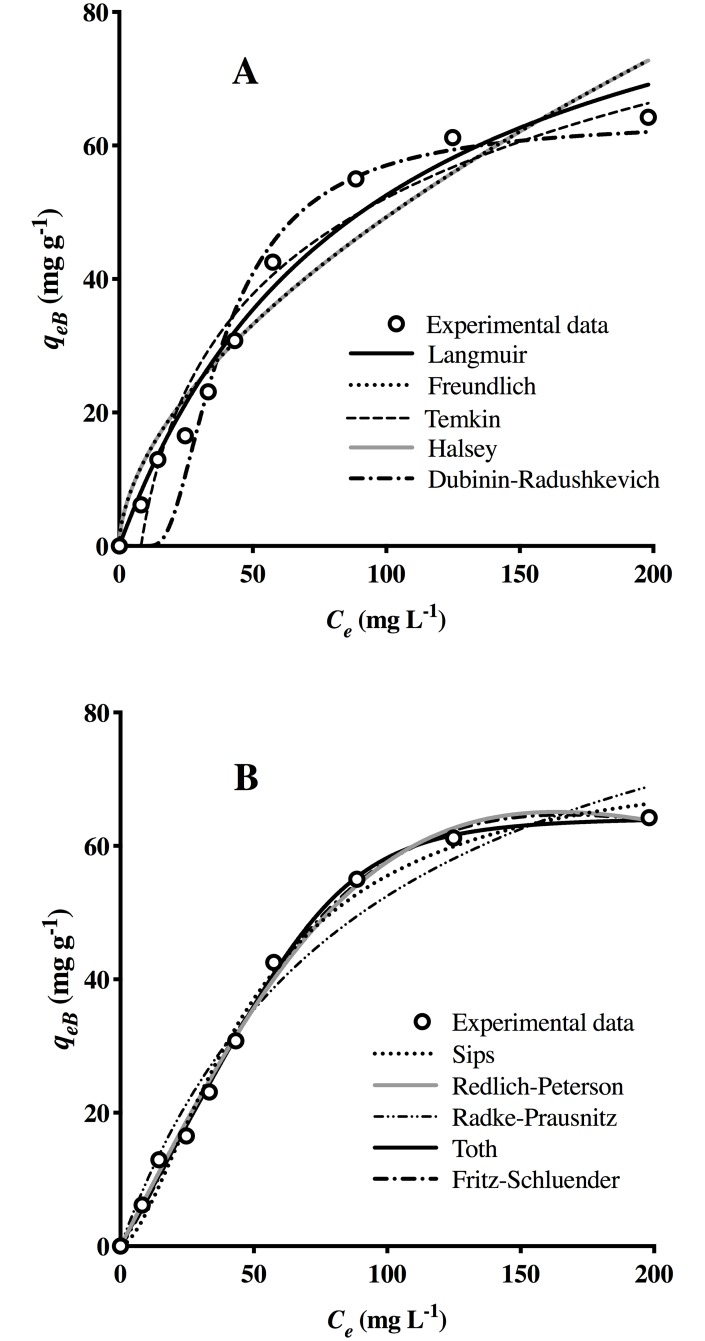
Two- (A) and three-parameter (B) isotherms for the biosorption of AO74 by HPL.